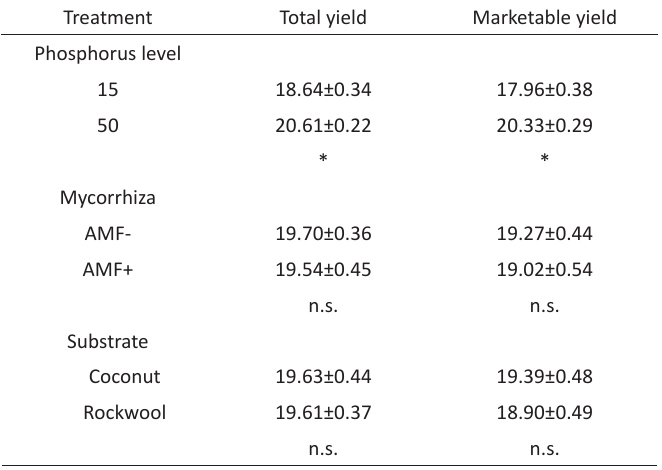
Table 2. The effect of phosphorus level in nutrient solution (mg dm -3 ), mycorrhiza, and type of substrate on yield of tomato fruits (kg m -2 ).